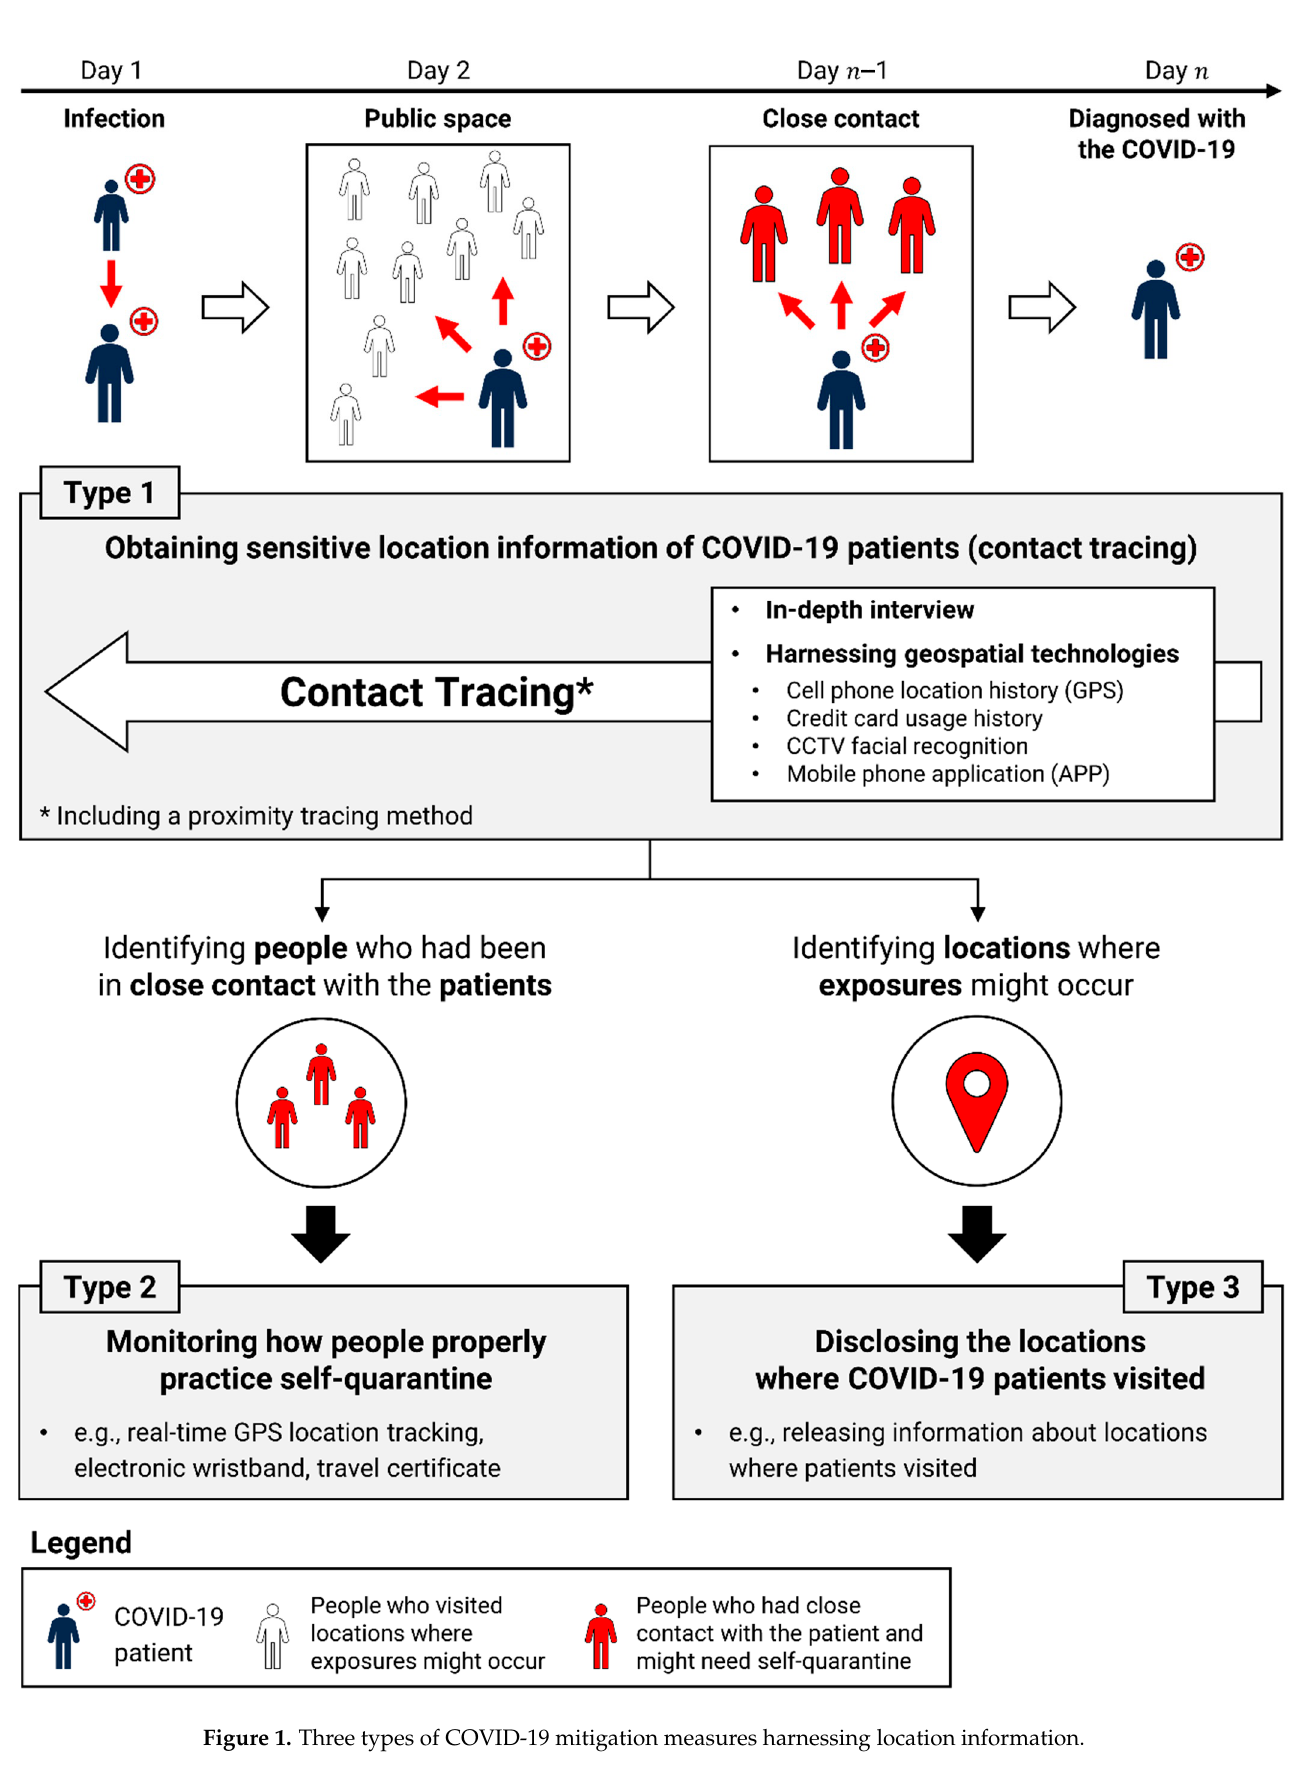
Figure 1. Three types of COVID-19 mitigation measures harnessing location information.